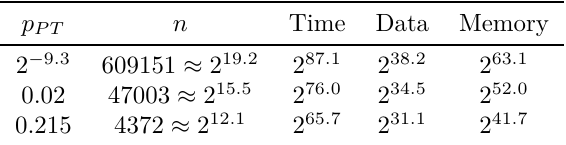
Figure 9: Required number of good ciphertext pairs for 50% probability of success in the ciphertext-only attack as a function of the probability p that two plaintexts differ only PT in the least significant eight bits. Table 4: Time, data and memory complexities of the ciphertext-only attack for some values of p . The data complexity values are dependent on traffic intensity. Here, 6 PT messages per minute are assumed. p PT n Time